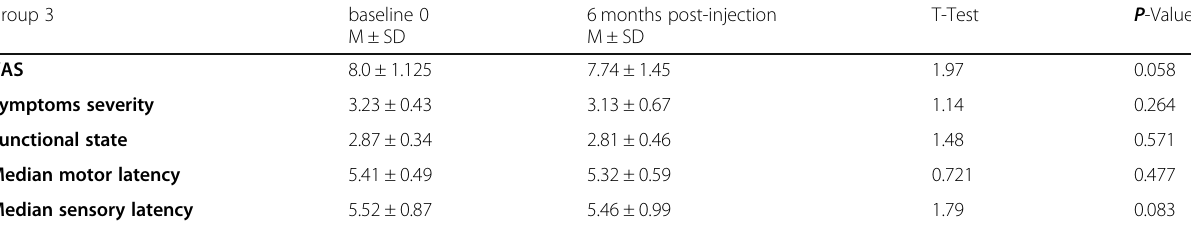
Table 4 Visual analogue scale, Boston questionnaire of CTS and electrophysiological parameters of median nerve in the third group of patients at 6 months post-medication compared to baseline parameters